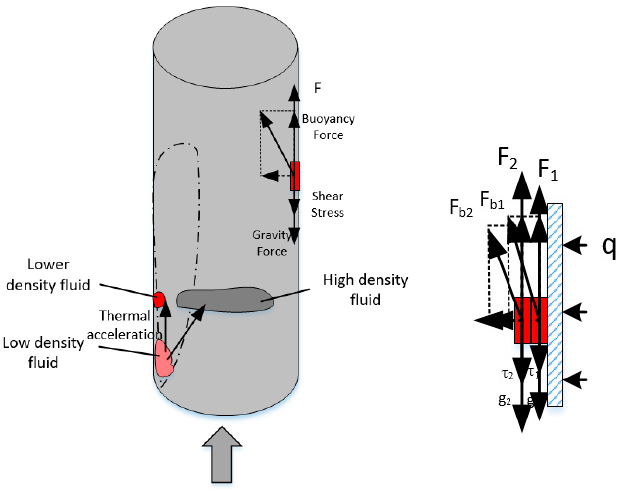
Figure 11. Force analysis of near-wall fluid in the vertical tube.